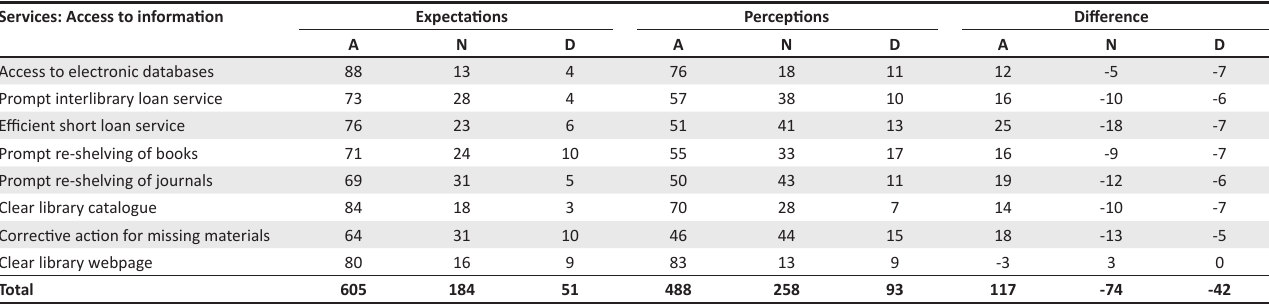
TABLE 2: Access to information.